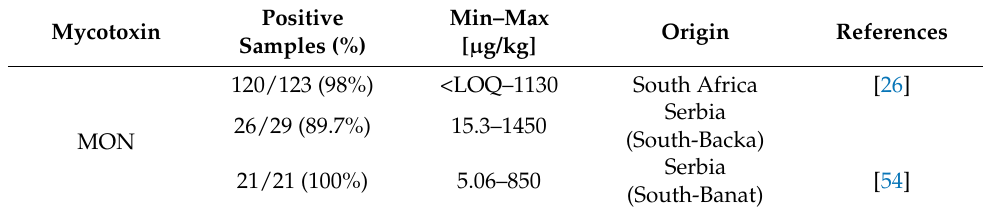
Table 5. Natural occurrence of emerging mycotoxins in